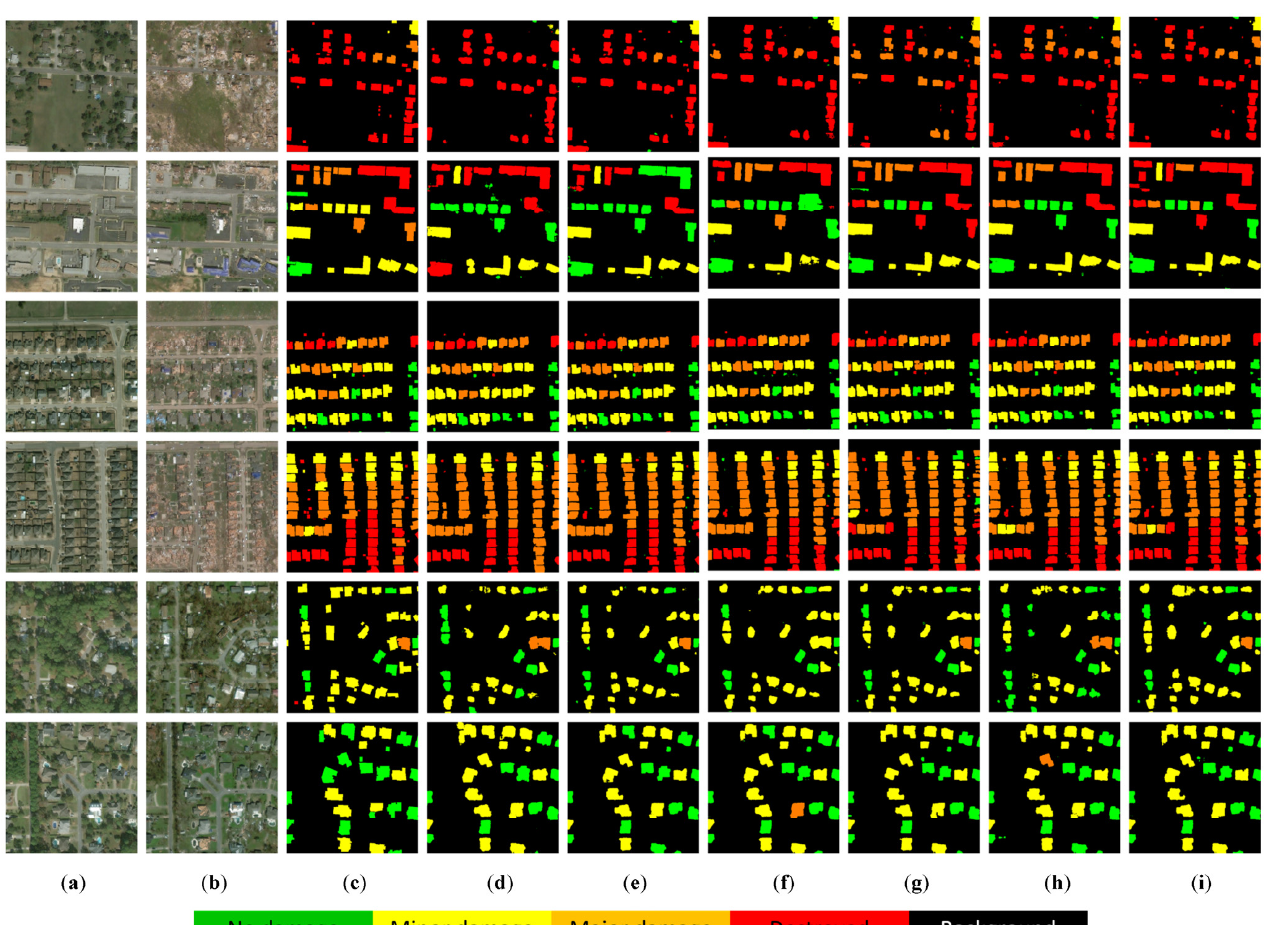
Figure 7. Visual comparison of damage assessment results with different SSL methods. ( a ) Pre-disaster image, ( b ) post-disaster image, ( c ) ground truth, ( d ) SL, ( e ) CutMix-Seg, ( f ) PseudoSeg, ( g ) CCT, ( h ) CPS, and ( i ) proposed SSL method.